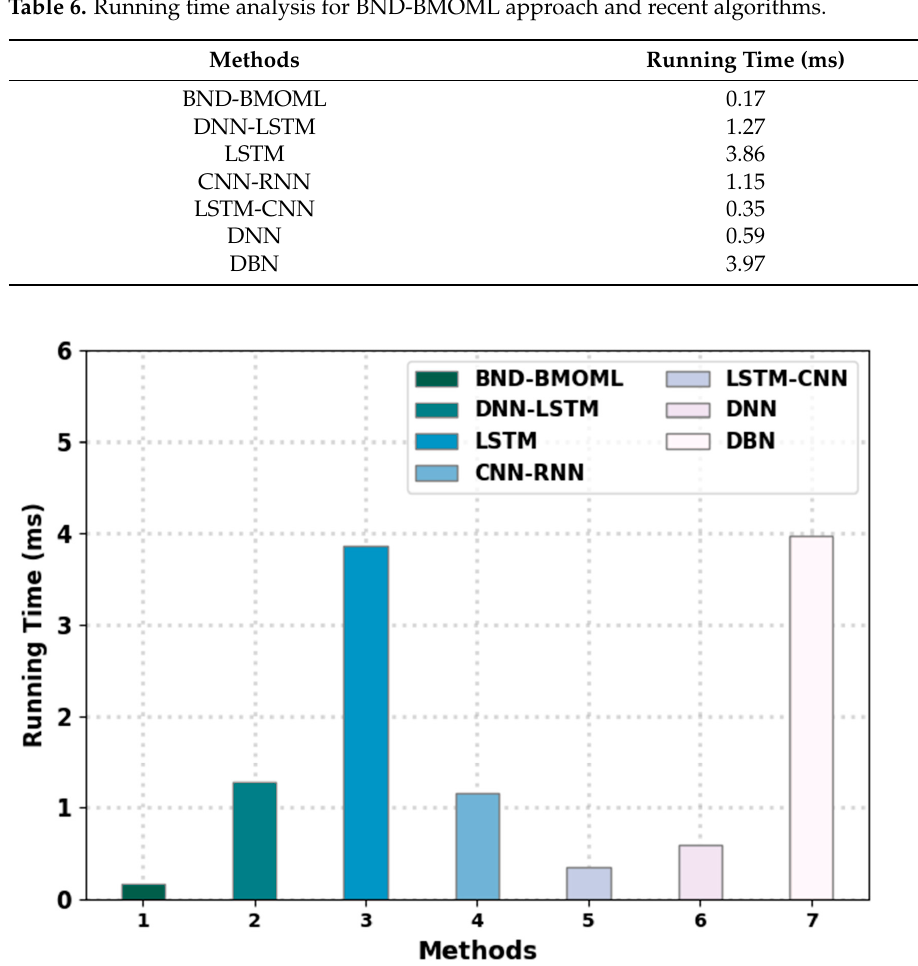
Figure 10. Comparative analysis of BND-BMOML approach and recent algorithms. Table 6. Running time analysis for BND-BMOML approach and recent algorithms.